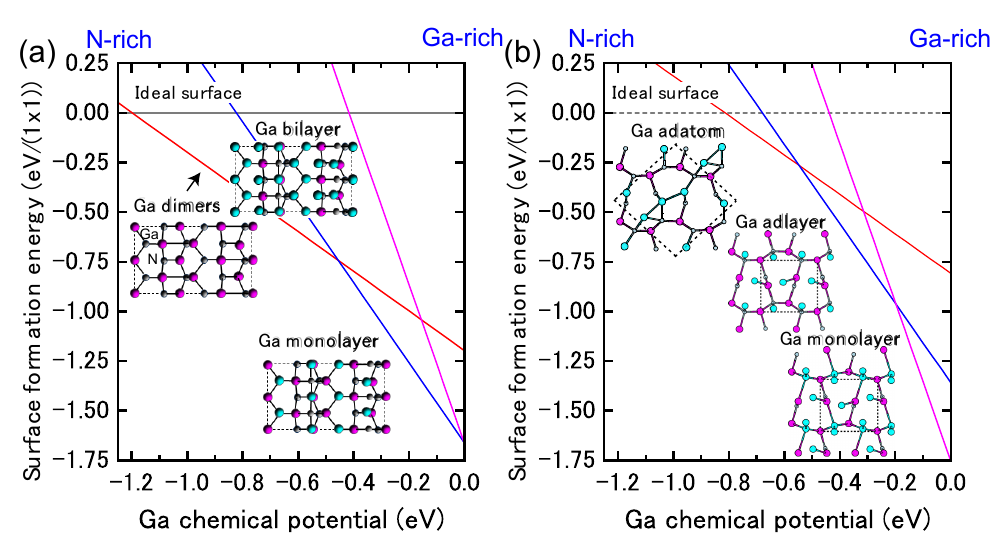
Figure 15. Calculated surface formation energies for semipolar GaN surfaces with _ _ ( a ) (1 1 01) and ( b ) (11 2 2) orientations as a function of the Ga chemical potential.